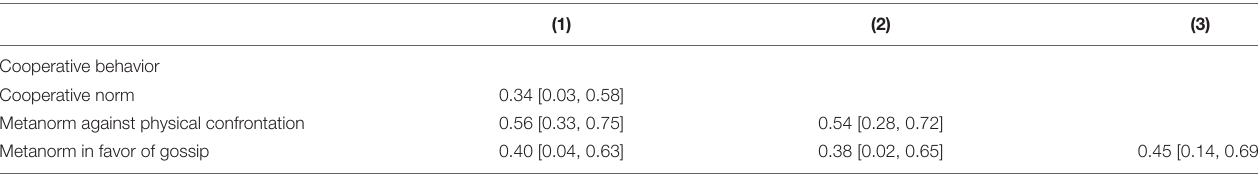
TABLE 2 | Pearson correlations between cooperative behavior, cooperative norms, and cooperative metanorms.